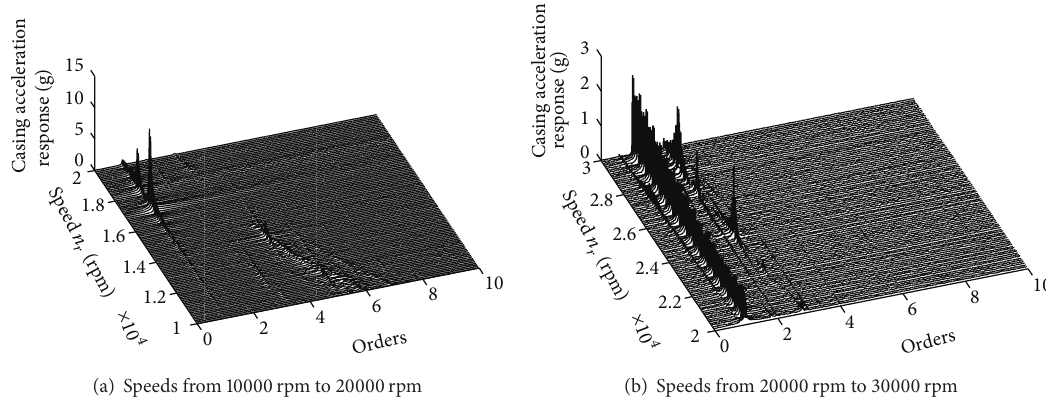
Figure 12: Cascade plot of the casing acceleration response at different